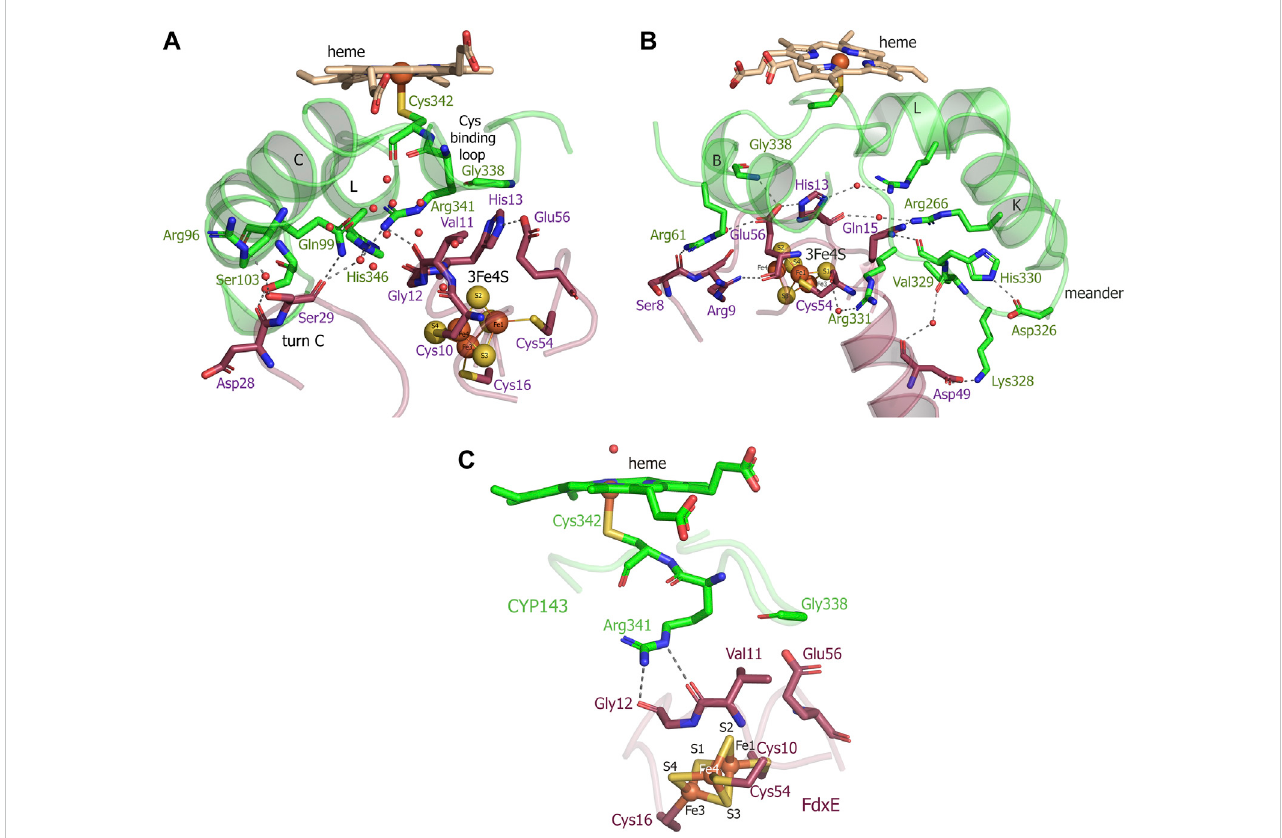
FIGURE 4 (A,B) Views of the interactions between FdxE and CYP143. (C) Residues important for mediating electron transfer coupling between the donor and acceptor. Coupled atomswere computed separately by selecting either Fe1 or Fe4 atoms of the [3Fe-4S] cluster as the donor using HARLEM. FdxE is colored raspberry and CYP143 —